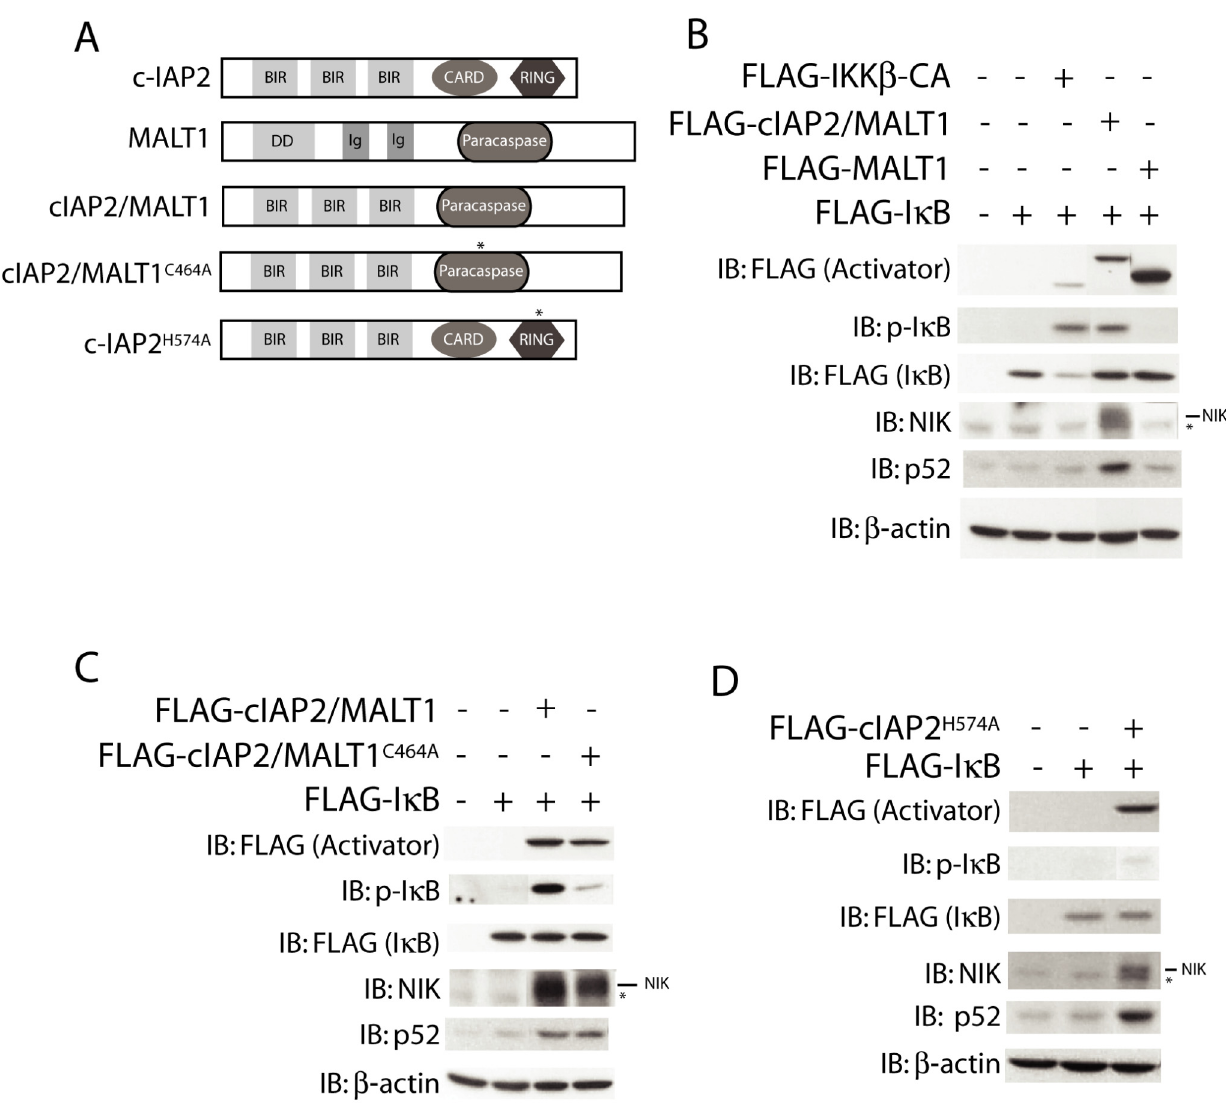
Figure 1. c-IAP2/MALT1 fusion protein activates canonical and non-canonical NF- k B signaling. (A) Schematic of c-IAP2, MALT1, c-IAP2/ MALT fusion protein, and other mutants used. * denotes the location of the inactivating mutations. (B, C, and D) c-IAP1/MALT fusion protein activates canonical and non-canonical NF- k B signaling pathways. Lysates prepared from 293T cells that had been transfected with the indicated cDNAs for 24 h were immunoblotted with anti-FLAG, anti-phospho-I k B, anti-NIK, and anti-p52 antibodies. Because of differences in molecular weight, one can use anti-FLAG to detect and distinguish between the NF- k B activating proteins (Activator: IKK b -CA, c-IAP2/MALT1, c-IAP2 H570A , and MALT1) and I k B. Some lanes were reordered for clarity. b -actin expression was used as a loading control. * denotes a non-specific